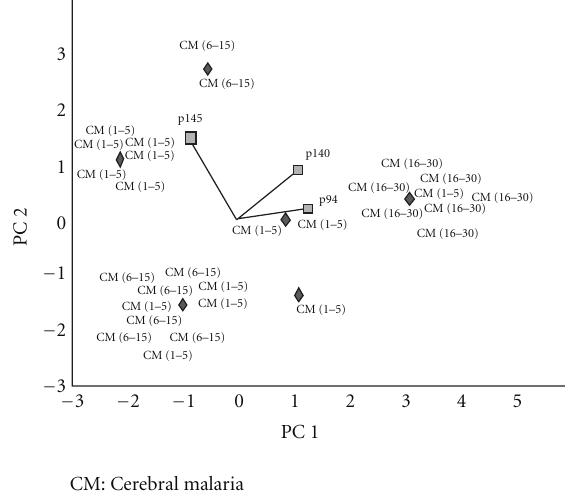
Figure 4: Relationship between p94 antigenic band and MEI with neurological manifestations. A two-dimensional principal component analysis (PCA) of all MEI with neurological mani- festations (termed cerebral malaria-CM) aged from 1 to 30 years was evaluated. The biplot of the data (PC 1 = x -axis versus PC 2 = y -axis) displays the correlation between the expression of the discriminatory bands (shown as lines) and the age group of CM patients (in italics for 1–5 years; in bold for 6–15 years; in normal characters for 16–30 years). For each patient, data dispersions were represented by the barycentre ( (cid:2) ). The position of the invidious relative to the three discriminant bands (shown as lines) reveals their relationship. In this view, p94 appears to be the best marker associated with CM aged to 16–30